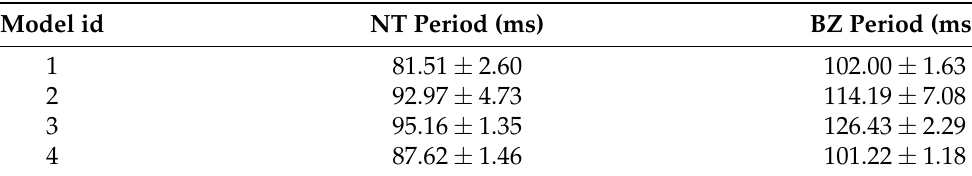
Figure 7. Spiral wave periods for the models from Figure 6 computed at an arbitrary point (100, 100) from the top left vertex of the tissue square. Table 4. Spiral wave periods in 2D simulations for normal tissue (NT) and border zone (BZ) tissue. Each value is given in the mean ± std